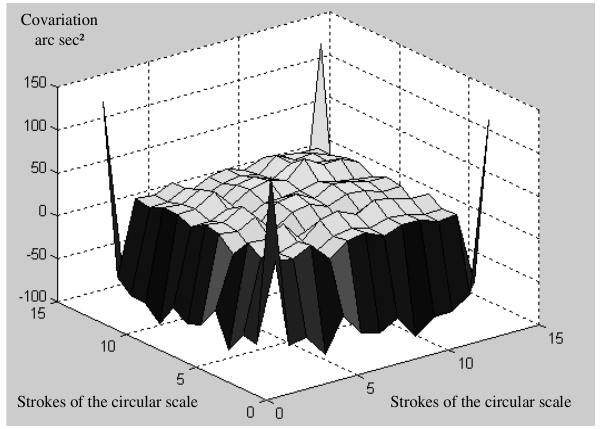
Fig 2 . Diagram of evaluation of covariation matrix of the circular scale’s strokes measurements